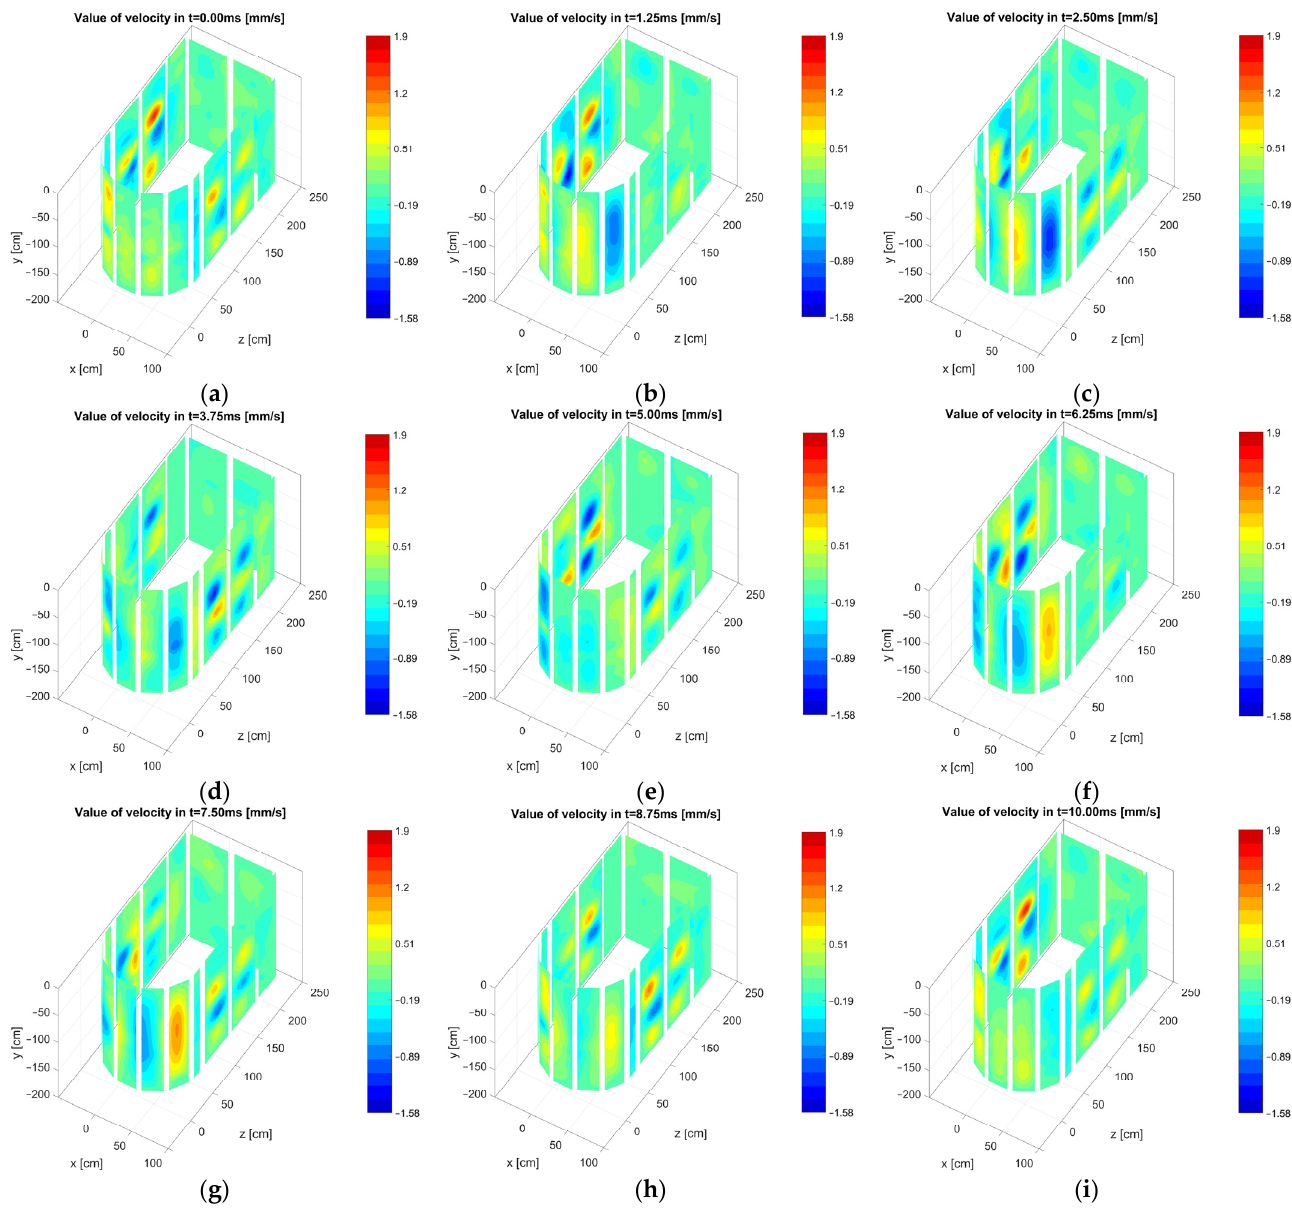
Figure 11. Visualization of the instantaneous amplitudes of the vibration velocity in 3D space in the time moments: ( a ) 0 ms, ( b ) 1.25 ms, ( c ) 2.5 ms, ( d ) 3.75 ms, ( e ) 5 ms, ( f ) 6.25 ms, ( g ) 7.5 ms, ( h ) 8.75 ms, and ( i ) 10 ms in the short-circuit test.